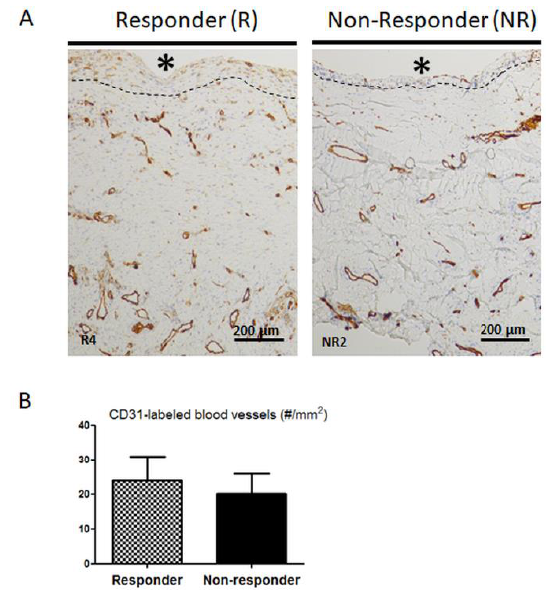
Figure 2. ( A ) CD31-positive mature blood vessels are found throughout both responder (R) and non-responder (NR) membranes, but predominantly in the deep layer in contact with the muscle and immediately beneath the PMMA-adjacent layer (dashed line). * indicates the PMMA site before its removal, scale bar = 200µm. ( B ) The number of CD31-labeled blood vessels was counted in six non overlapping microscopic fields of the induced membranes. Results are shown as the mean +/− SEM.